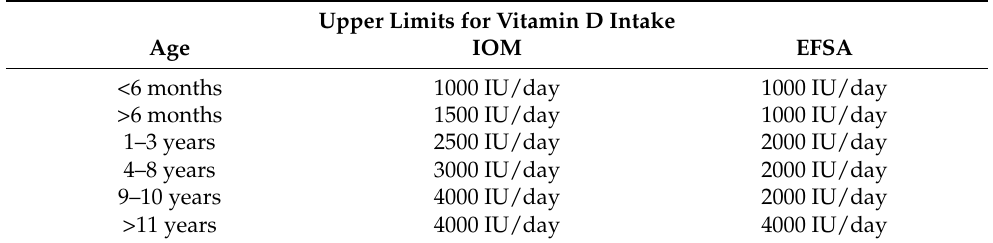
Table 2. Upper limits of vitamin D intake at different ages considering the IOM and EFSA guide- lines